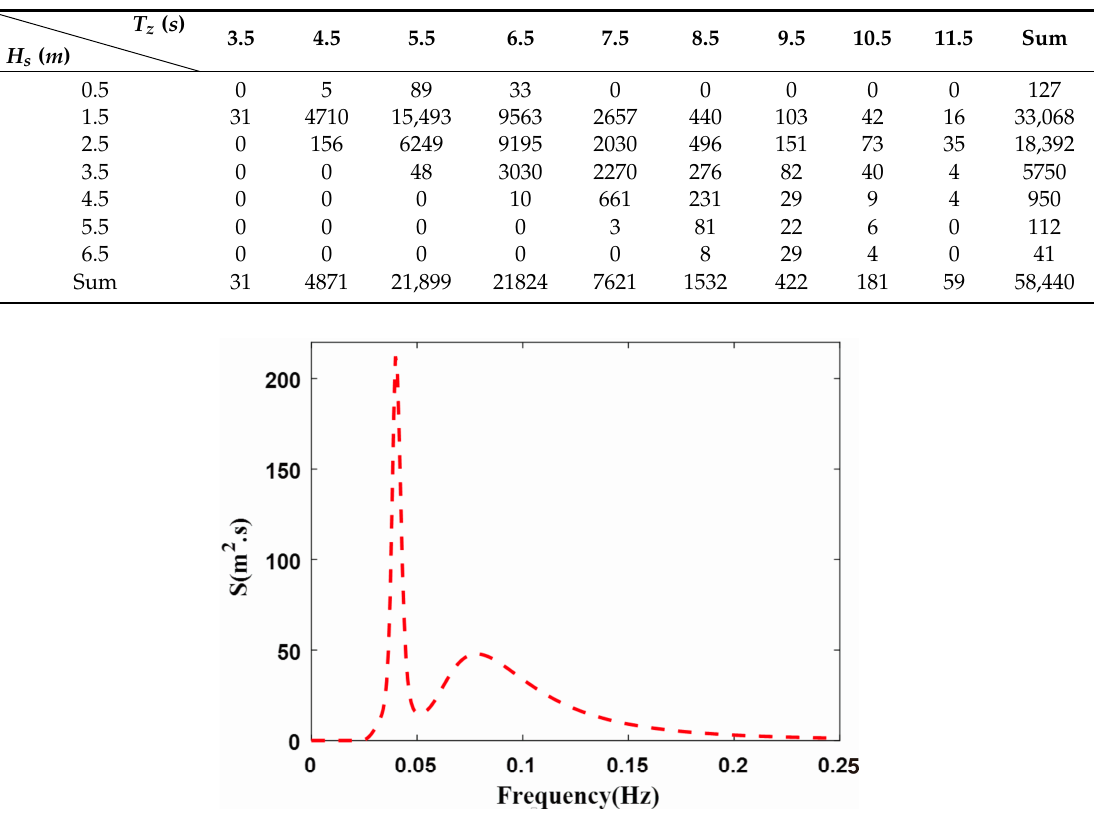
Figure 16. Double-peaked wave spectrum for load case 3 (LC3). Table 7. Load cases (LCs). PM—Pierson–Moskowitz; DP—double-peaked Torsethaugen